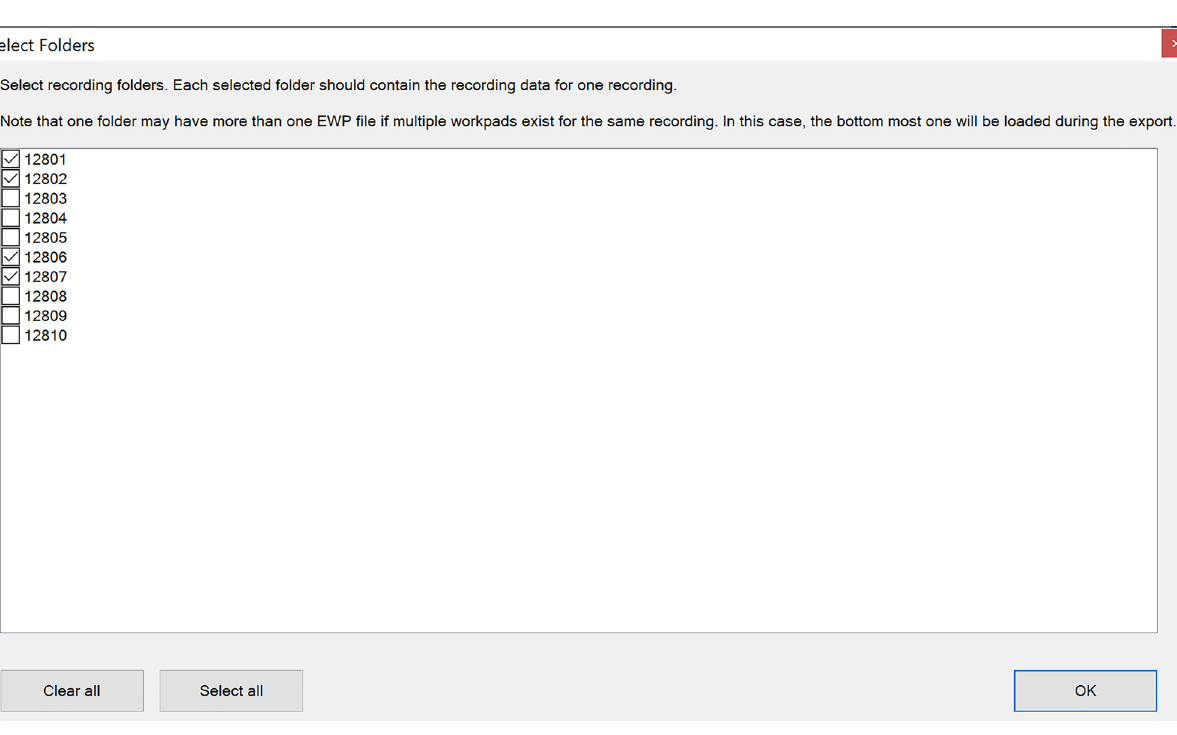
Figure 4. Recording selection